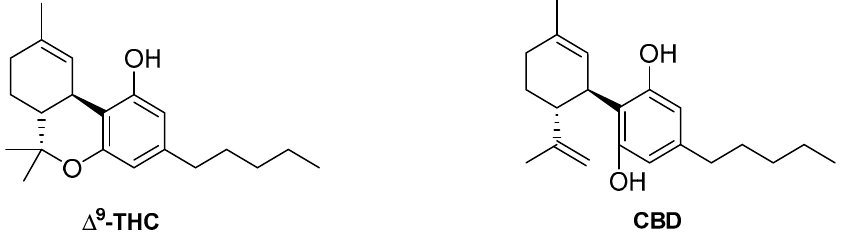
Figure 6. Structures of the plant-derived ligands ( − ) ∆ 9 -tetrahydrocannabinol ( ∆ 9 -THC) and cannabidiol (CBD).